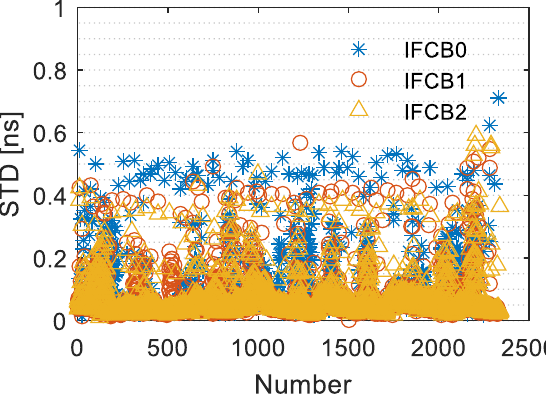
Figure 7. The STD of the one-day arc solutions with fixed coordinates from three handle schemes.